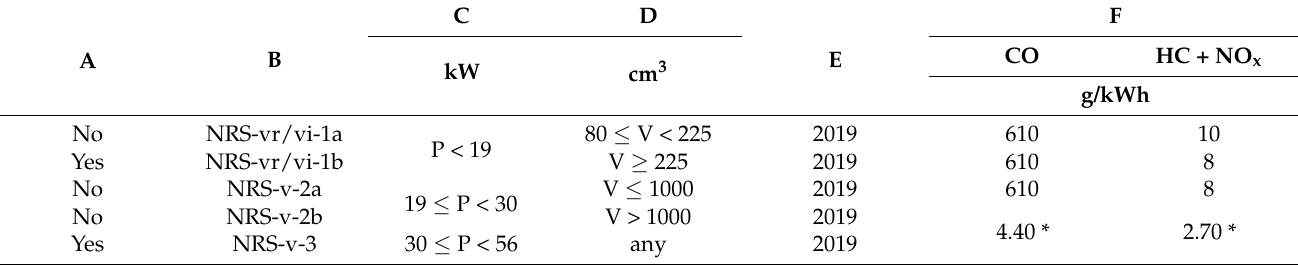
Table 3. Stage V emission standards for non-handheld SI engines below 56 kW (NRS), where: A—the availability of selected categories of engines used in fans for rescue operations on the European market, B—category, C—power (P), D—displacement (V), E—date of entry into force, F—emission limits for hazardous exhaust gas compounds during European type approval tests [33]. C